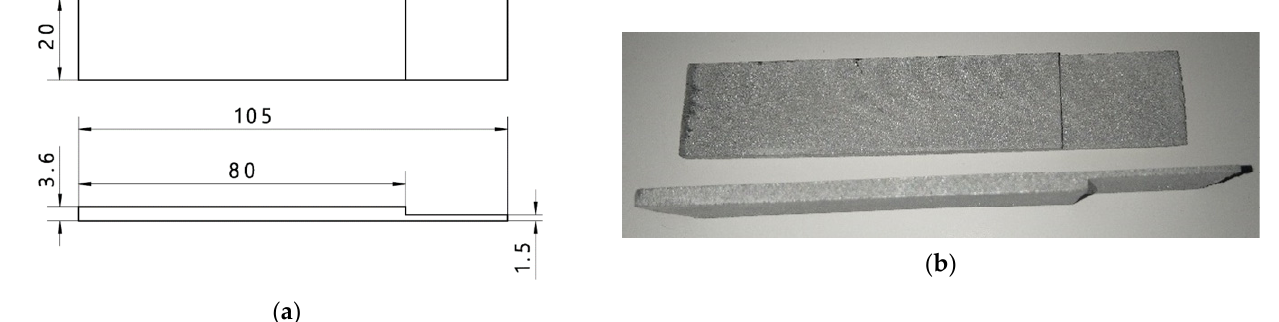
Figure 1. Samples used during the test; ( a ) scheme with dimension, ( b ) view of the sample.